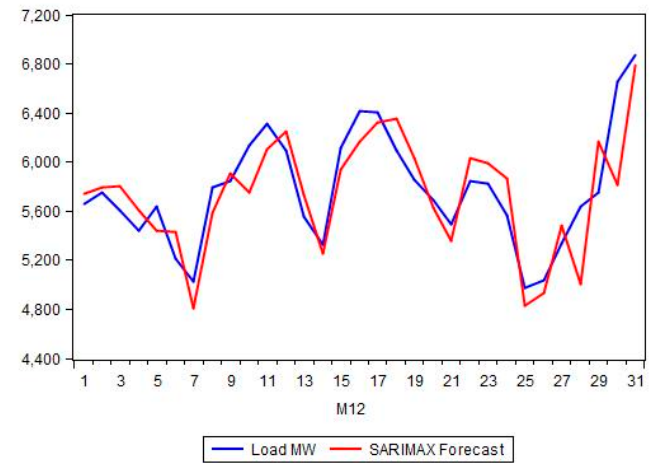
Figure 16. SARIMAX forecasts for December 2014.